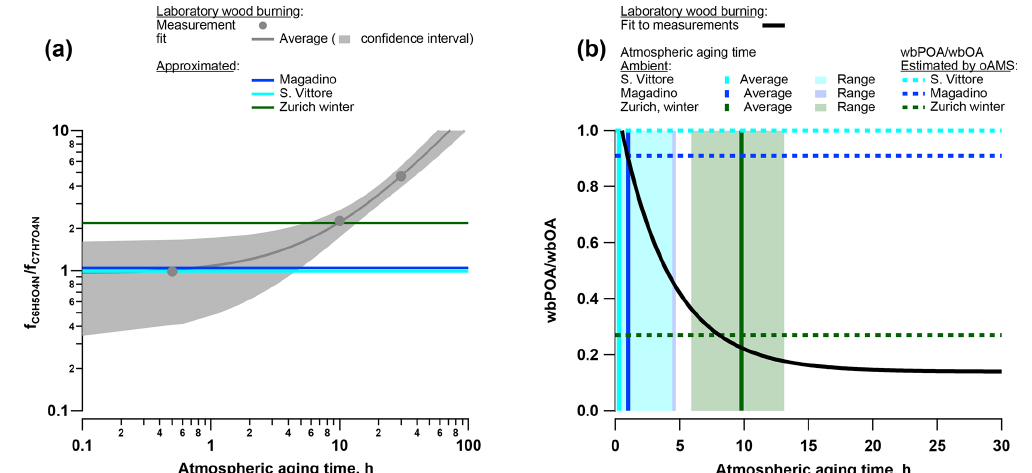
Figure 11. (a) Atmospheric aging parameterized as a function of the ratio of the fraction of total signal related to C 6 H 5 O 4 N ( f C /f C C 7 H 7 O 4 N ( f C ); f C for the wood-burning smog chamber experiments and estimated atmospheric aging time of 7 H 7 O 4 N 7 H 7 O 4 N 6 H 5 O 4 N the wood-burning emissions for the ambient analysis in Zurich (winter), Magadino, and San Vittore. (b) Fraction of primary wood-burning